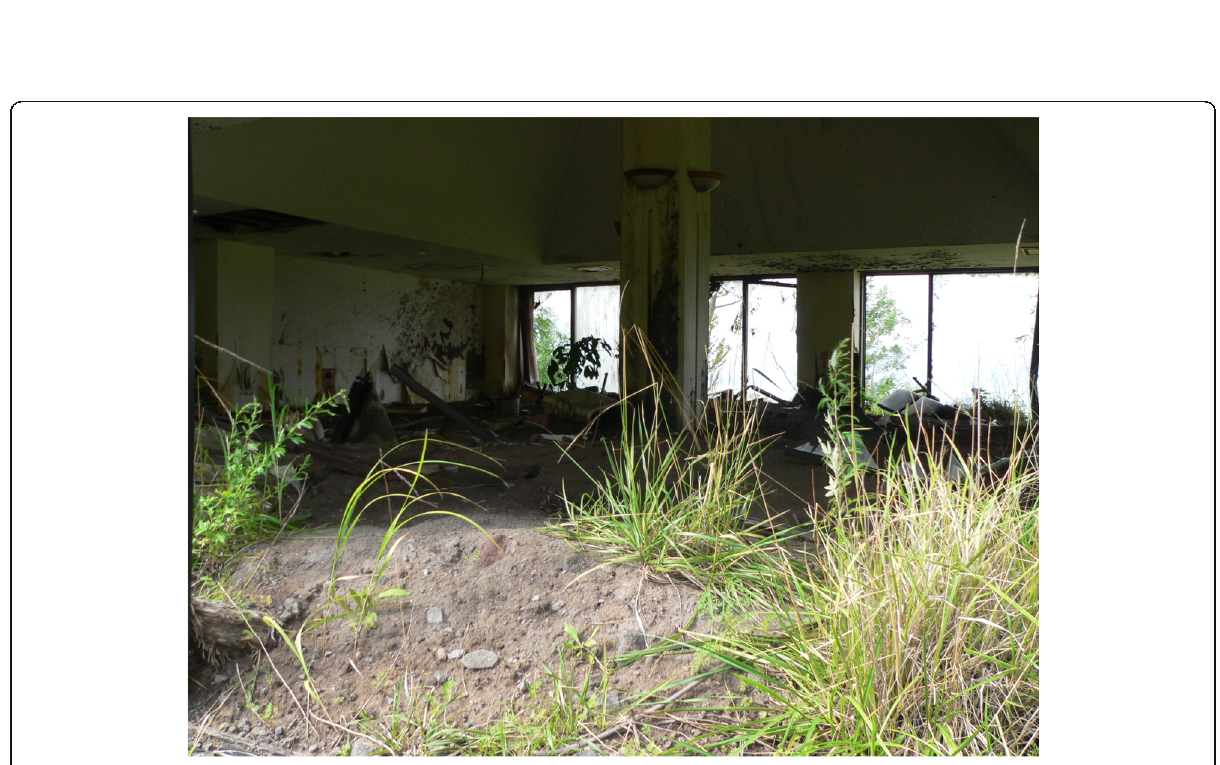
Fig. 20 Lahar deposit emplaced within a residential area at Mt Usu, Hokkaido in 2000. While this eruption caused extensive damage to houses and infrastructure, it caused no human casualties, due to close monitoring of the volcano and efficient hazard mitigation